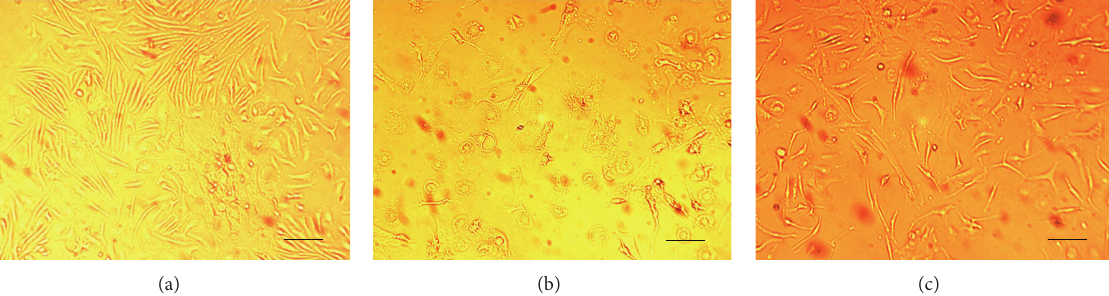
Figure 2: The role of Baicalin in survival of the decidua cells: (a) control group, (b) LPS group, and (c) Baicalin group. The bars represent 100 𝜇